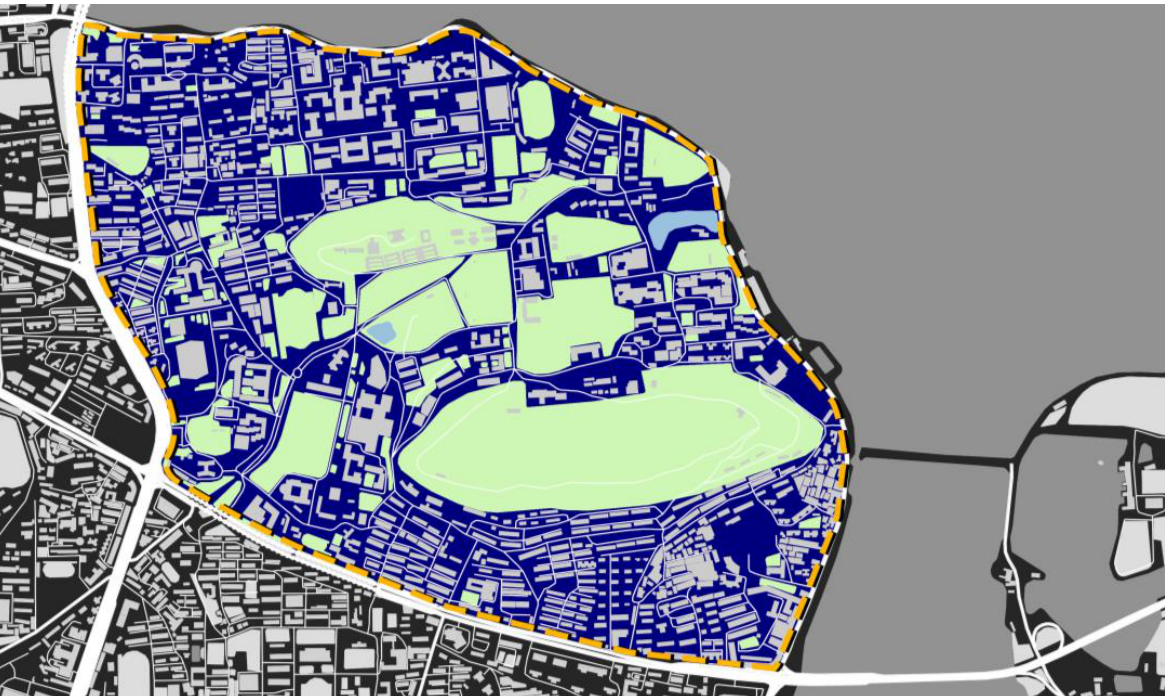
Figure 2. Study site and boundary of the campus, Wuhan University, Wuhan, China.